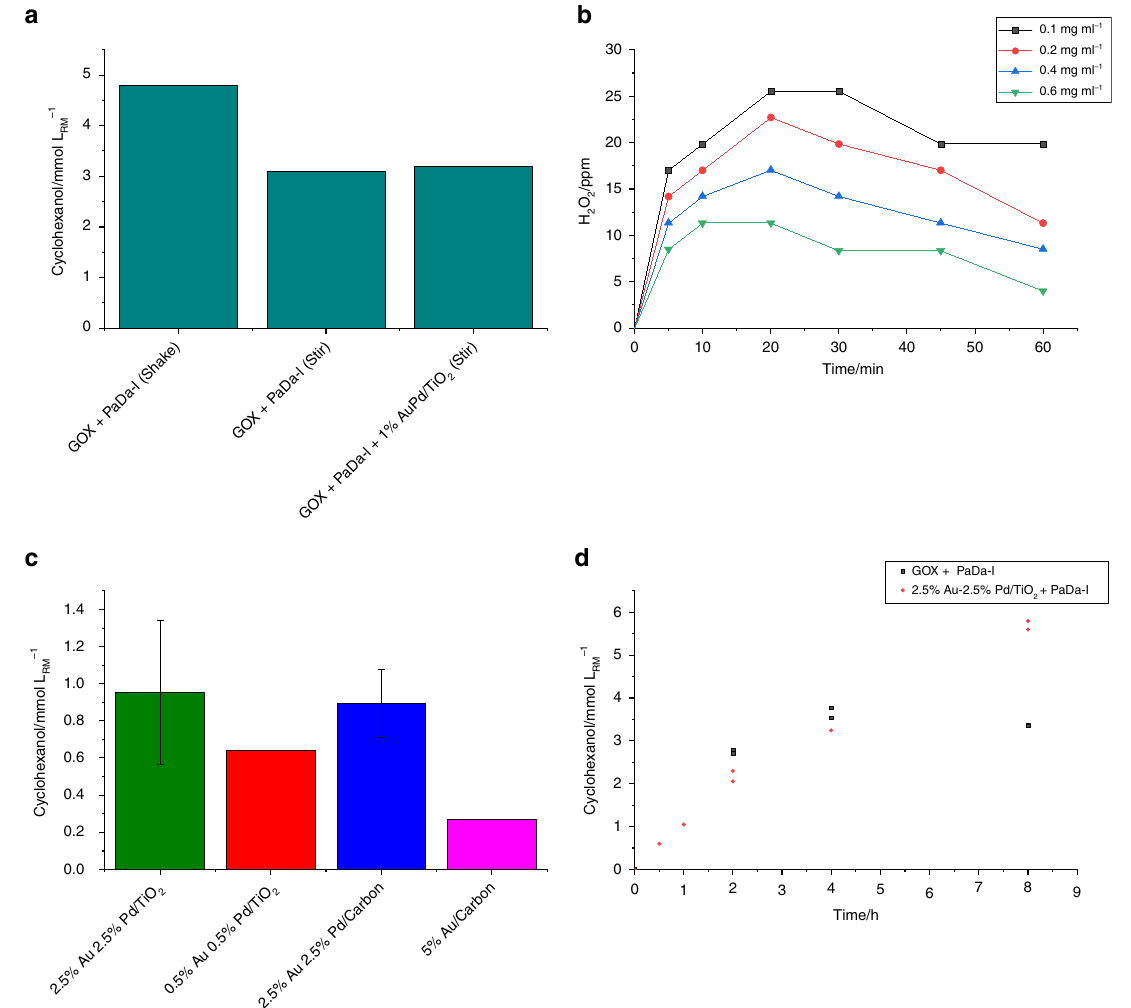
Fig. 2 Feasibility of Coupling Catalytic Systems. a Cyclohexanol production in control reactions to determine the effect of the metal catalyst on unspeci fi c peroxygenase activity when H 2 O 2 is generated using GOX. b H 2 O 2 synthesis with various catalyst concentrations under fl owing (30 ml min − 1 ) 80% H 2 in air. Reaction Conditions: Solvent (H 2 O) 50 ml, ambient temperature and pressure, gas fl ow 30 ml min − 1 , 500 rpm stirring. Errors associated in the measurement of H 2 O 2 by titration were ± 3 ppm. c Cyclohexane conversion to cyclohexanol using PaDa-I (15 U ml RM − 1 ) in potassium phosphate buffer (100 mM, pH 6) and H 2 O 2 generated in situ by metal catalysts. Ef fi ciency of different AuPd catalysts (0.5 mg ml − 1 ) in the presence of 77% H 2